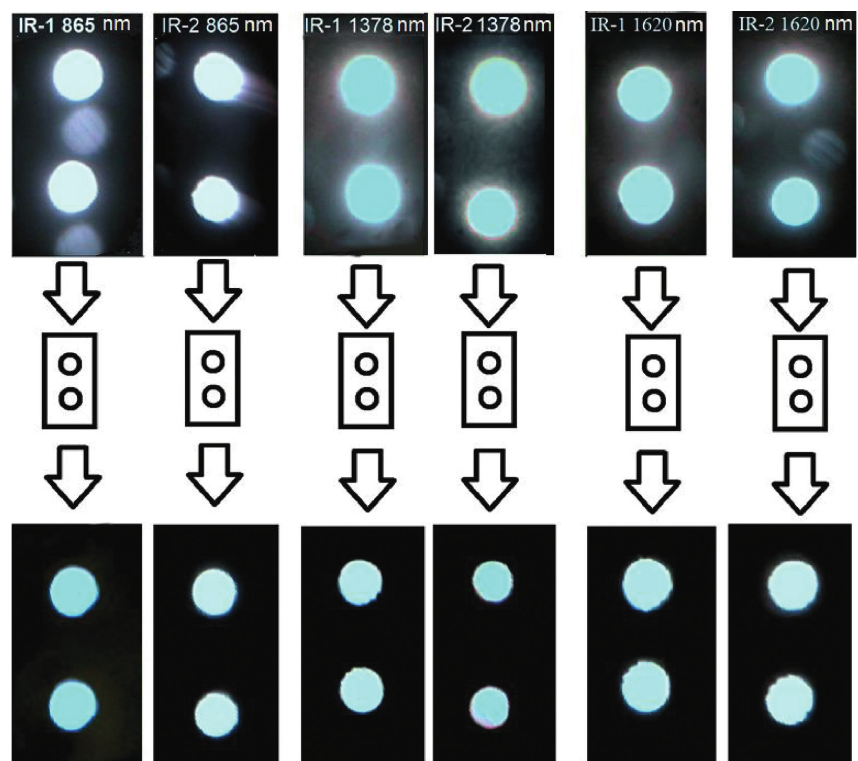
Figure 17: Image of field diaphragm in the focal planes of camera lenses for IR-1 and IR-2 units before and after input of blocking